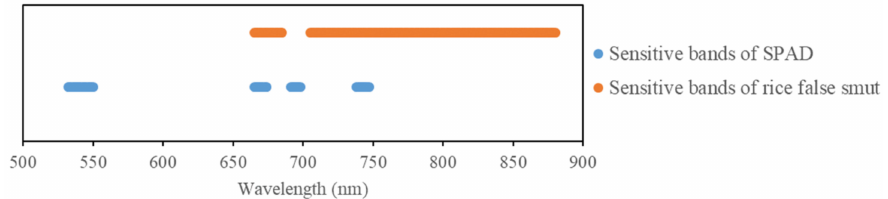
Figure 16. Sensitive bands of rice false smut and